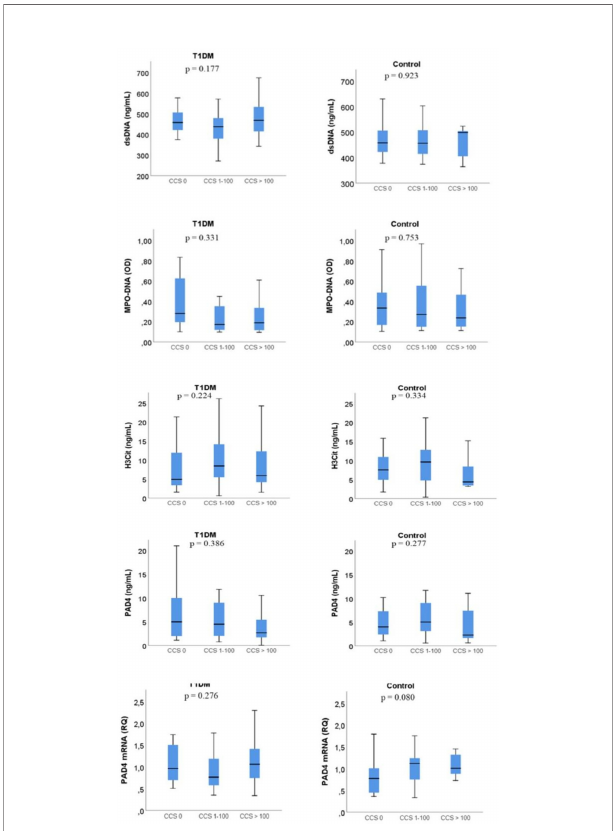
FIGURE 4 | NETs marker levels according to coronary calcium score (CCS). Boxplot- The line inside the boxes represent the median, the box boundaries the 25th and 75th percentiles, while the lower and upper lines represent the 10th and 90th percentiles. T1DM, type 1 diabetes mellitus; dsDNA, double- stranded deoxyribonucleic acid; MPO-DNA, myeloperoxidase-DNA; H3Cit, citrullinated histone 3; PAD4, peptidylarginine deiminase 4. The p-value refer to difference between the three